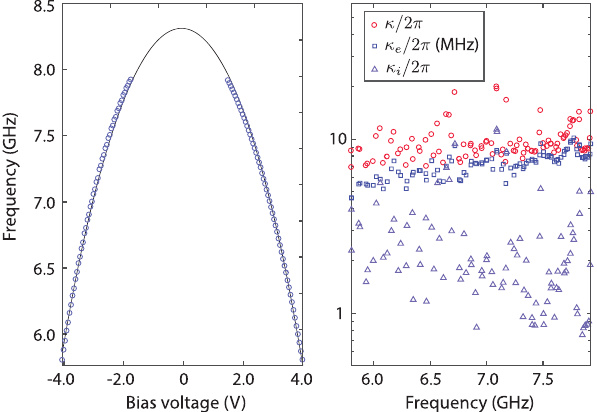
FIG. 5. Wide band resonator characterization. Calibration of the external flux as a function of the applied bias voltage (left panel), including data points (circles) and fit to theory. The flux sweet 8 . 31 GHz lies outside our measurement band. spot at ω r; max ¼ The total, extrinsic, and intrinsic linewidths ( κ , κ , and κ , e i respectively) are also plotted as a function of frequency. A monotonic decrease in κ as the resonator is tuned towards the i flux sweet spot may be due to a reduction in the flux noise contribution to the